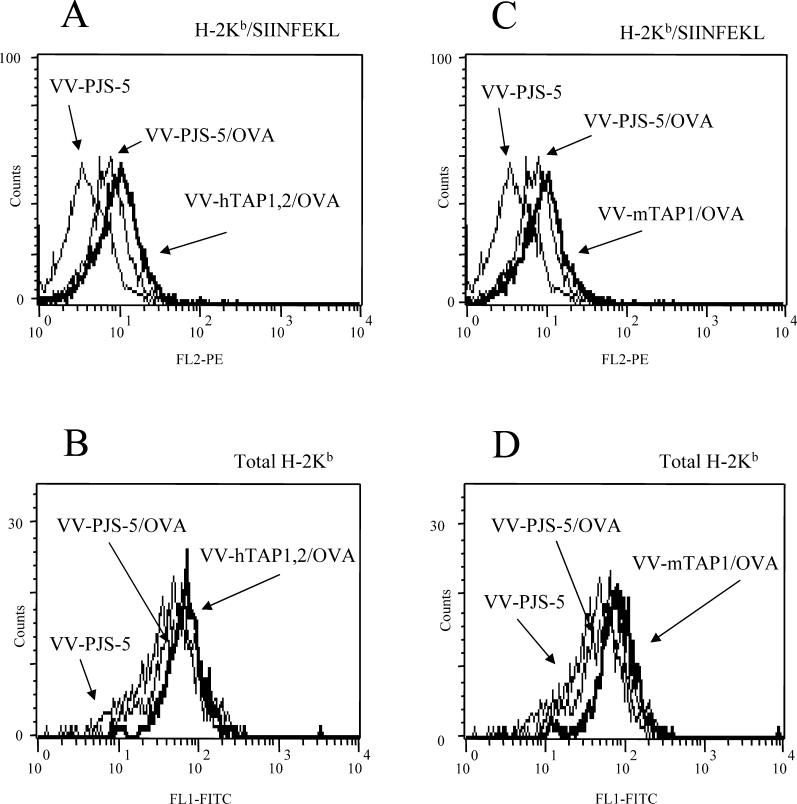
The Effect of VV-hTAP1,2 and VV-mTAP1 Infection on the Cross-Presentation Activity of OVA/SIINFEKL by Normal Spleen-Derived DCsDCs infected with VV-hTAP1,2 expressed greater (A) H-2Kb–SIINFEKL and (B) total H-2Kb than DCs infected with VV-PJS-5. DCs infected with VV-mTAP1 also expressed greater (C) H-2Kb–SIINFEKL and (D) total H-2Kb than DCs infected with VV-PJS-5. DCs infected with VV-PJS-5, but not incubated with OVA, served as negative controls for cross-presentation. The data are representative of the experiment performed in duplicate.